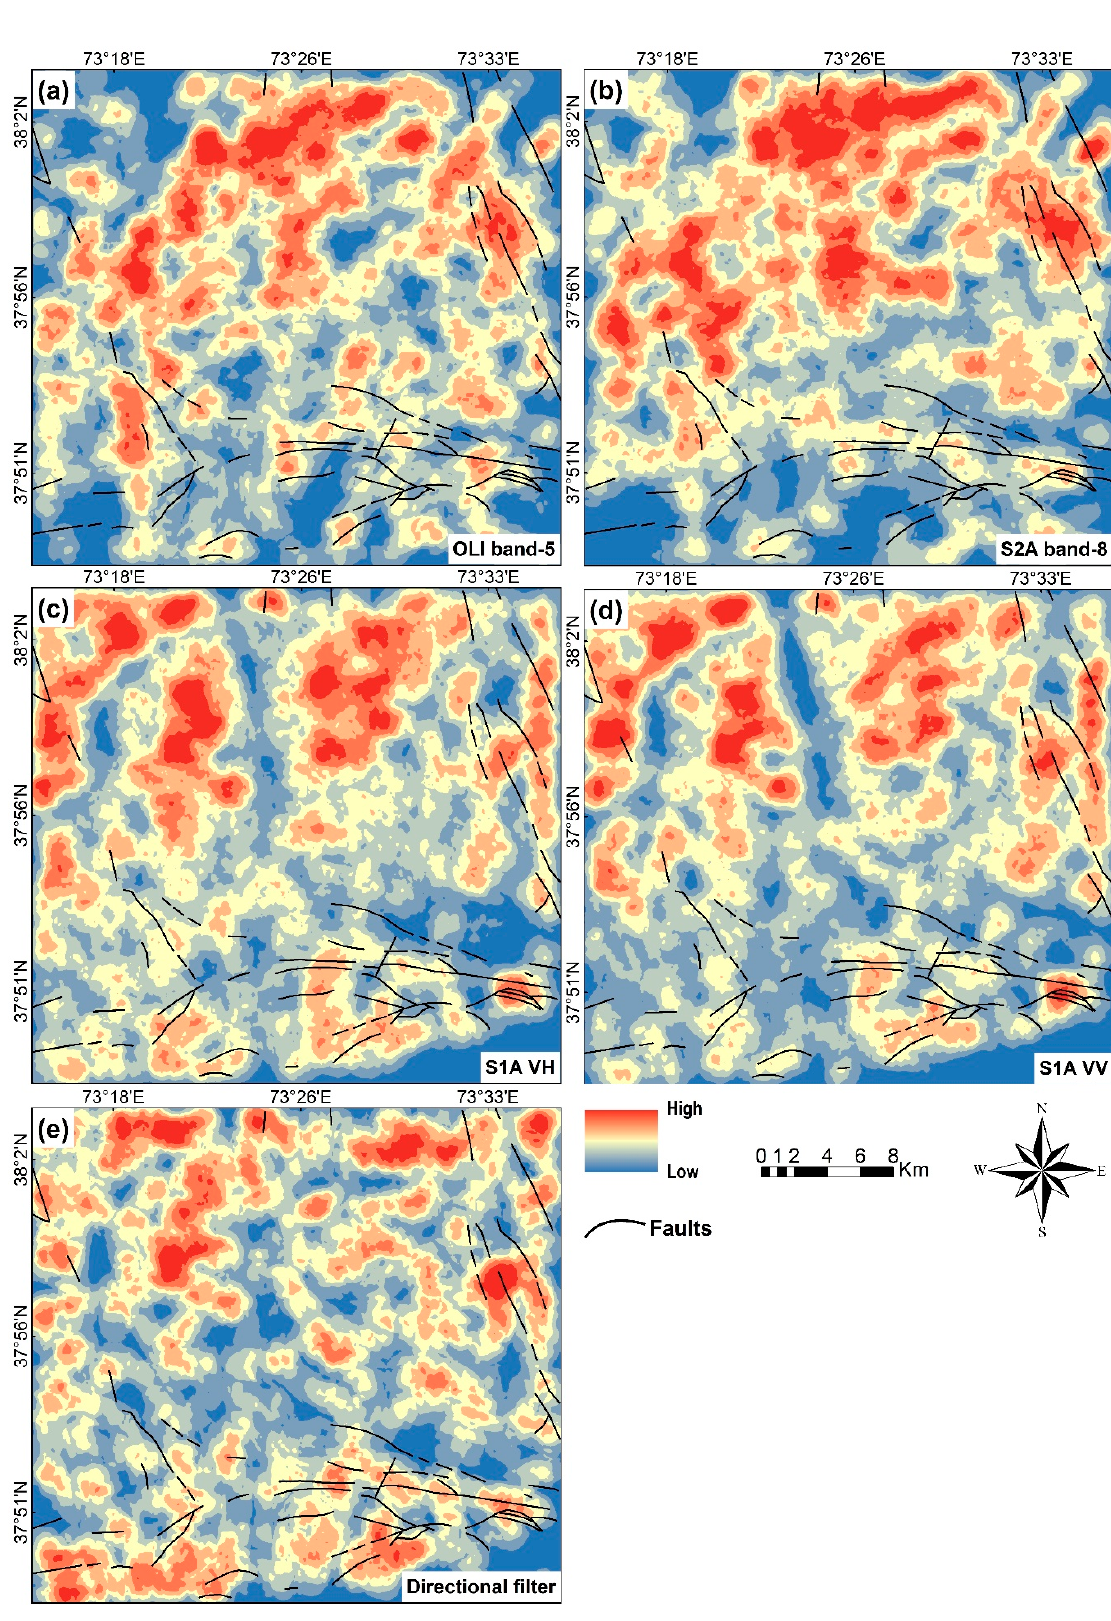
Figure 12. The density maps of the extracted lineaments for the ( a ) OLI band-5, ( b ) S2A band-8, ( c , d ) S1A VH and VV polarizations respectively, and ( e ) the manually extracted lineaments overlain by the faults digitized from a geological map [94,95].